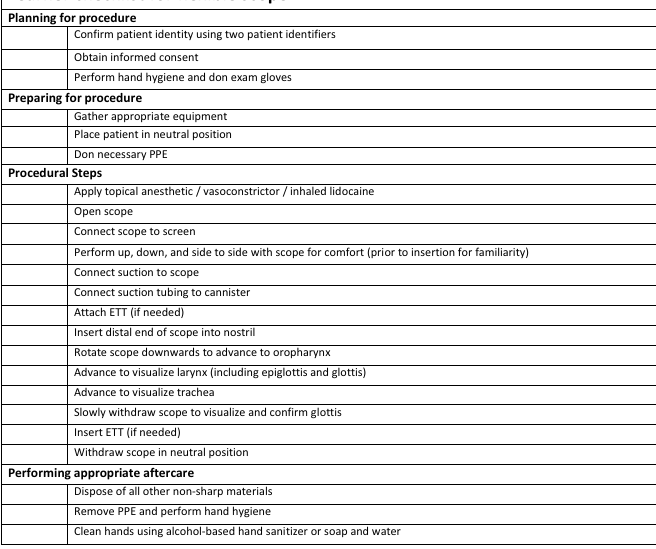
Figure 1. Learner checklist for flexible scope. PPE , personal protective equipment; ETT , endotracheal tube.